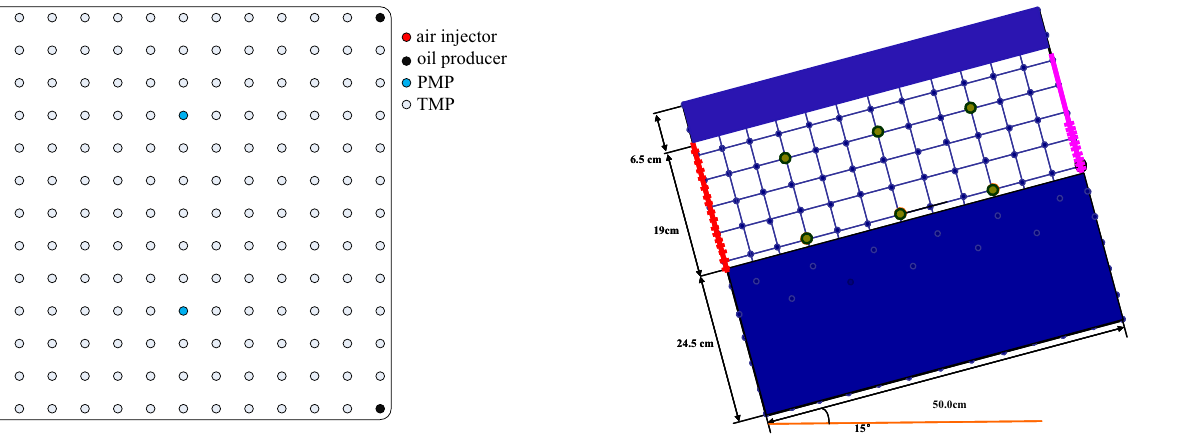
Fig. 3 The model of 40-m-thick reservoir with structural dip of